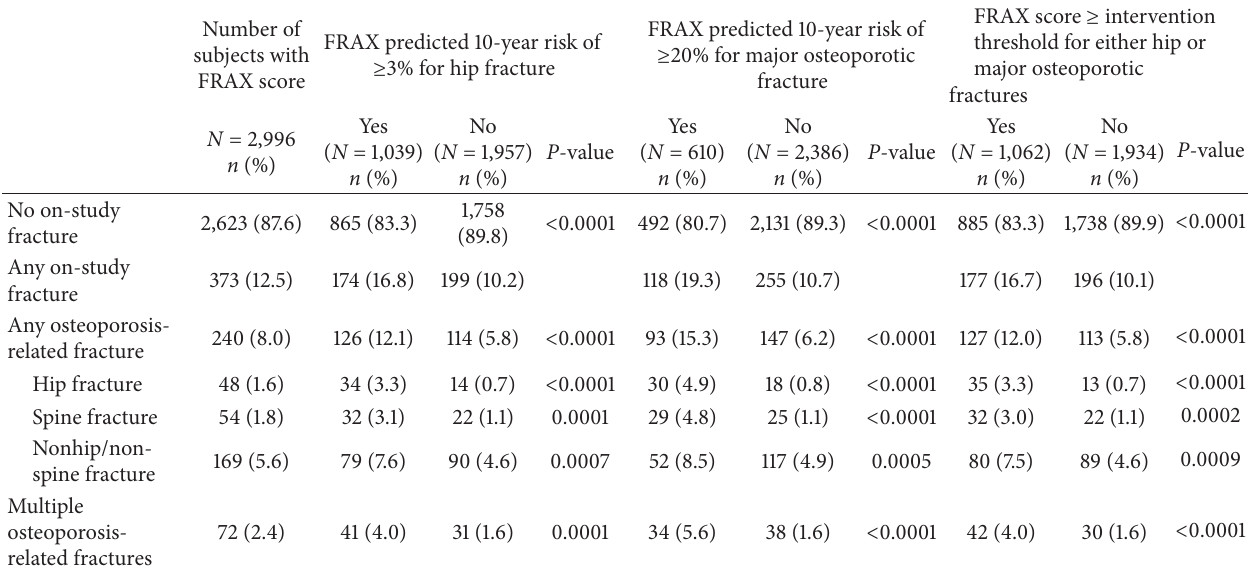
Table 4: Self-reported on-study fracture among pharmacologically treated a POSSIBLE US subjects stratified by the National Osteoporosis Foundation treatment